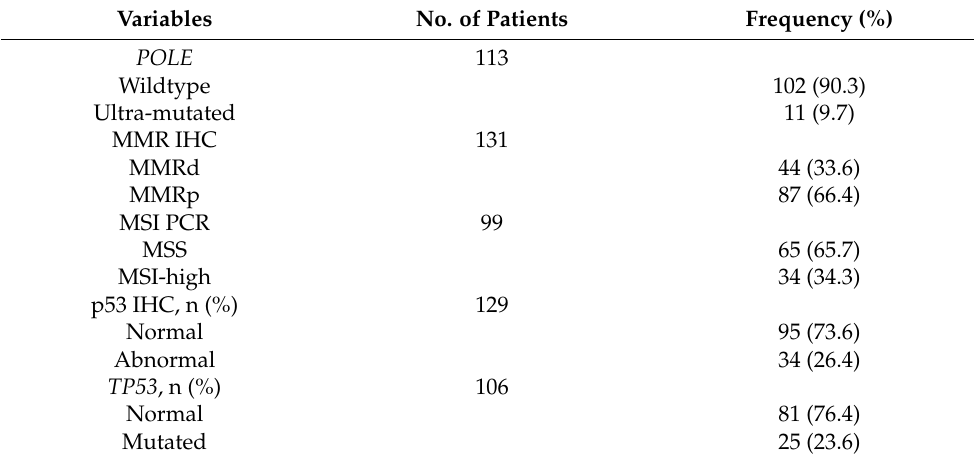
Table 2. Molecular profile of EC tumours ( n =